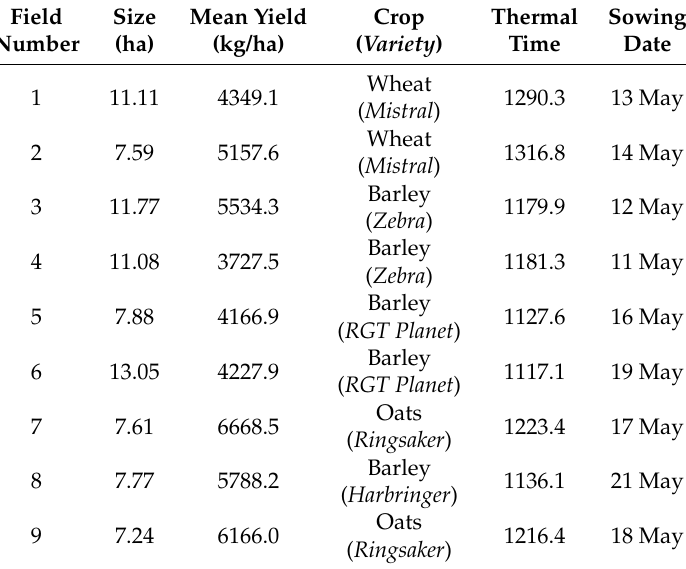
Table 1. The fields selected for the study in the proximity of Pori, Finland. The thermal time is calculated as the cumulative sum of temperature between the sowing and harvest dates. Mean yield has been calculated from processed yield sensor data for each field.